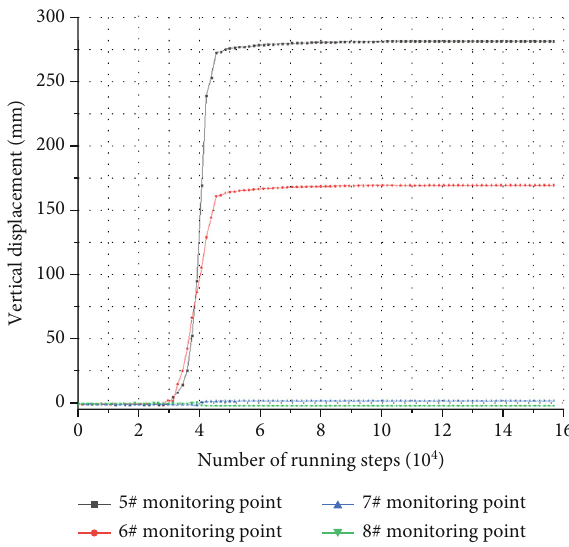
Figure 19: Vertical displacement change of the slope foot monitoring point.